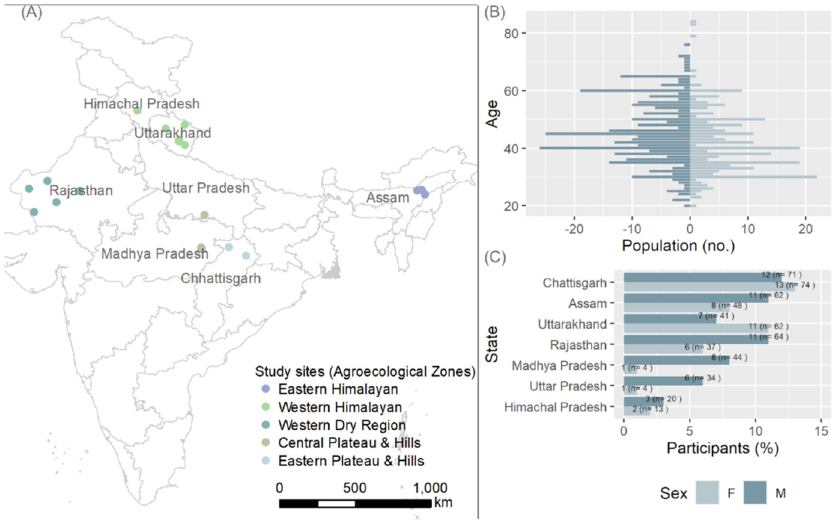
Figure 2. ( A ) Study site location across states and agroecological zones; ( B ) focus group discussion on population characterization across age and sex groups; and ( C ) states and sex groups ( C ). Num- bers in c) represent the total percentage and the n per state/sex group. in ( C ) represent the total percentage and the n per state/sex